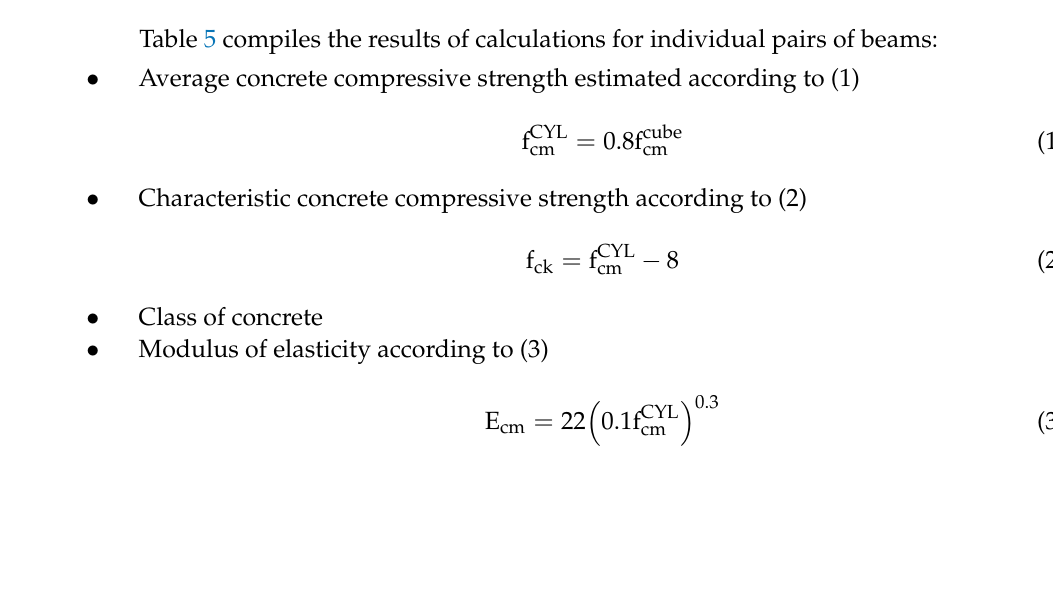
Table 5 compiles the results of calculations for individual pairs of